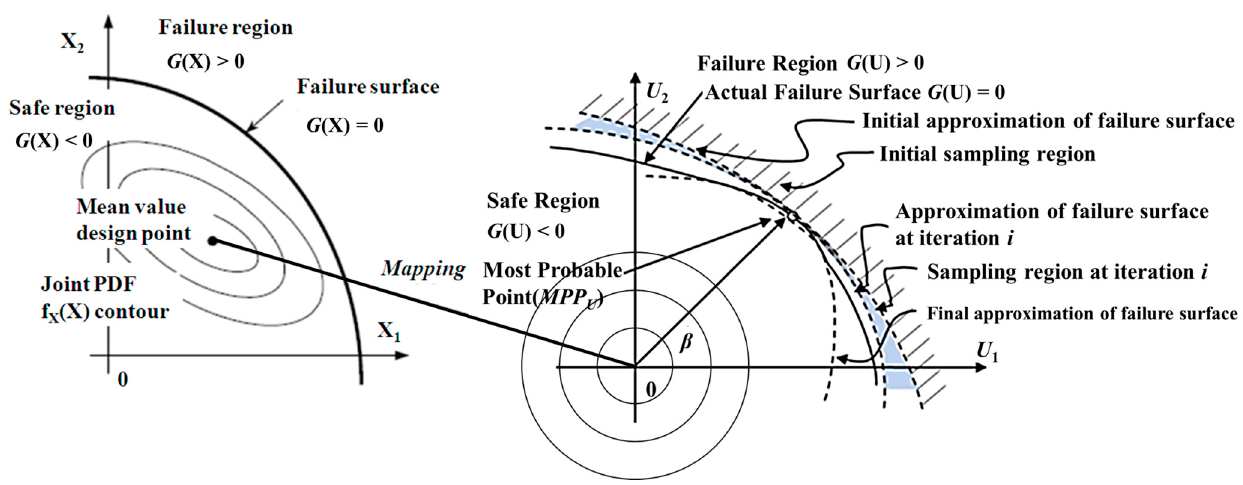
Figure 8. Failure region in AISM [28].